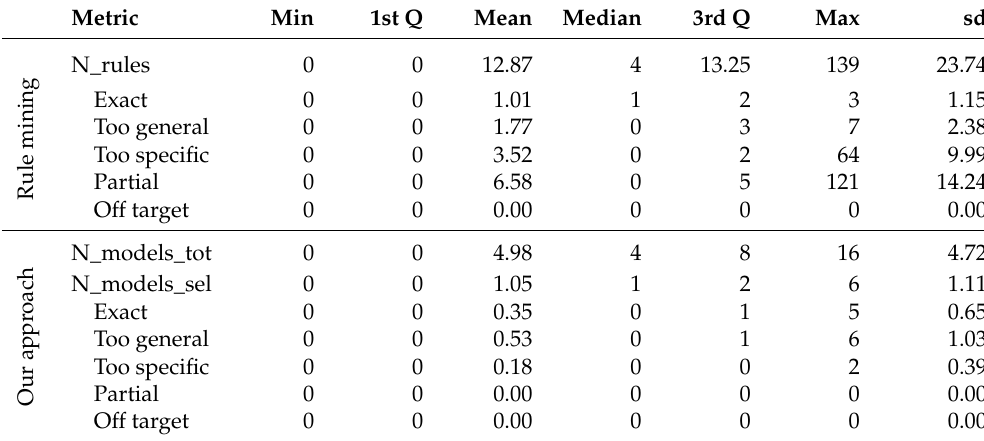
Table 5. Min, max, mean, median, first and third quantile of the number of rules (first group of rows) and models (second group of rows) obtained in each